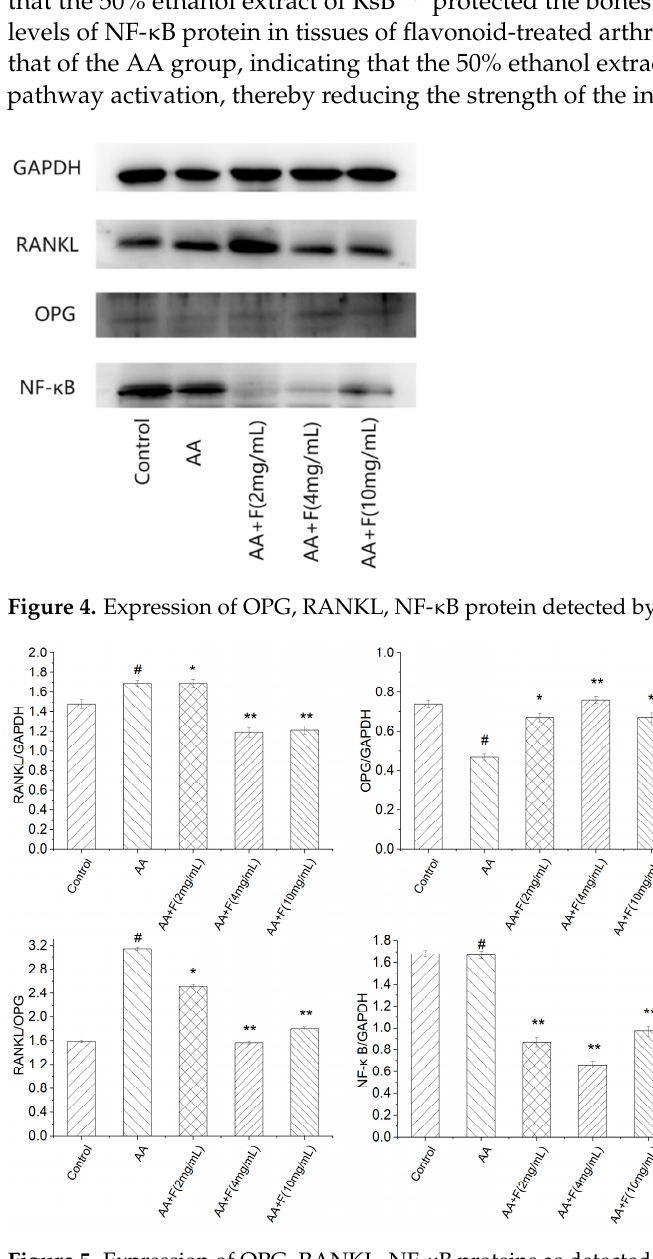
Figure 5. Expression of OPG, RANKL, NF ‐κ B proteins as detected via Western blot analysis (x ± SD). Error bars represent standard deviations ( n = 3). As compared with the control group, # p < 0.05 indicated that the arthritis model (AA) group was established successfully, as evidenced by decreased expression of OPG and NF ‐κ B proteins and increased expression of RANKL protein in the AA group. As compared with the AA group, * p < 0.05 and ** p < 0.01 indicated that extract ‐ treated arthritis model (AA+F) groups exhibited increased expression of OPG protein and decreased expression of RANKL protein and significant inhibition of the NF ‐κ B pathway.